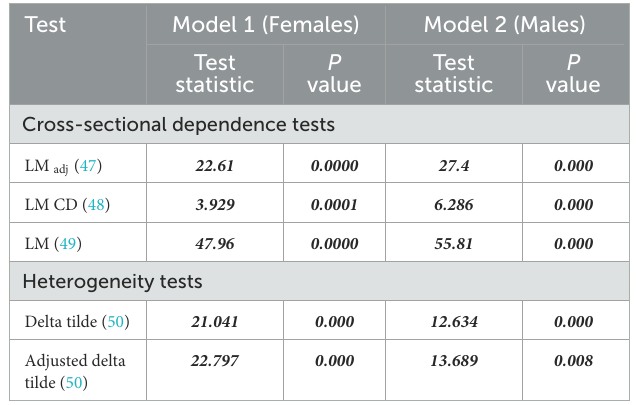
TABLE 4 Results of cross-sectional dependence and heterogeneity